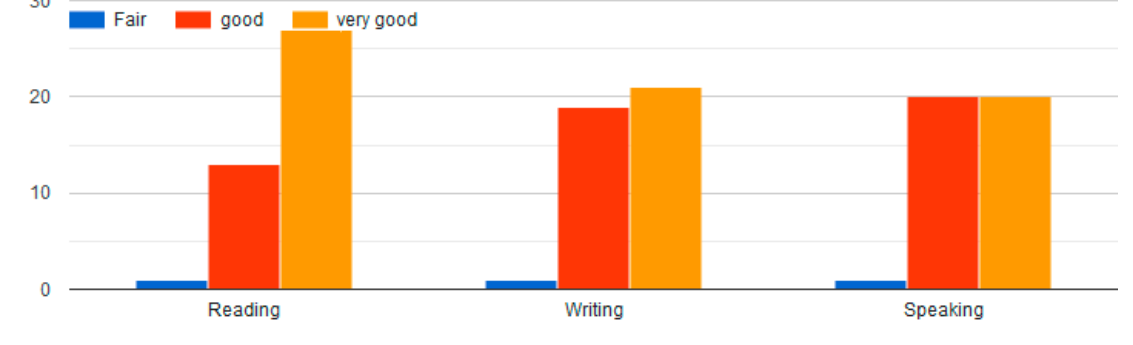
Figure 13. Programmer English level.